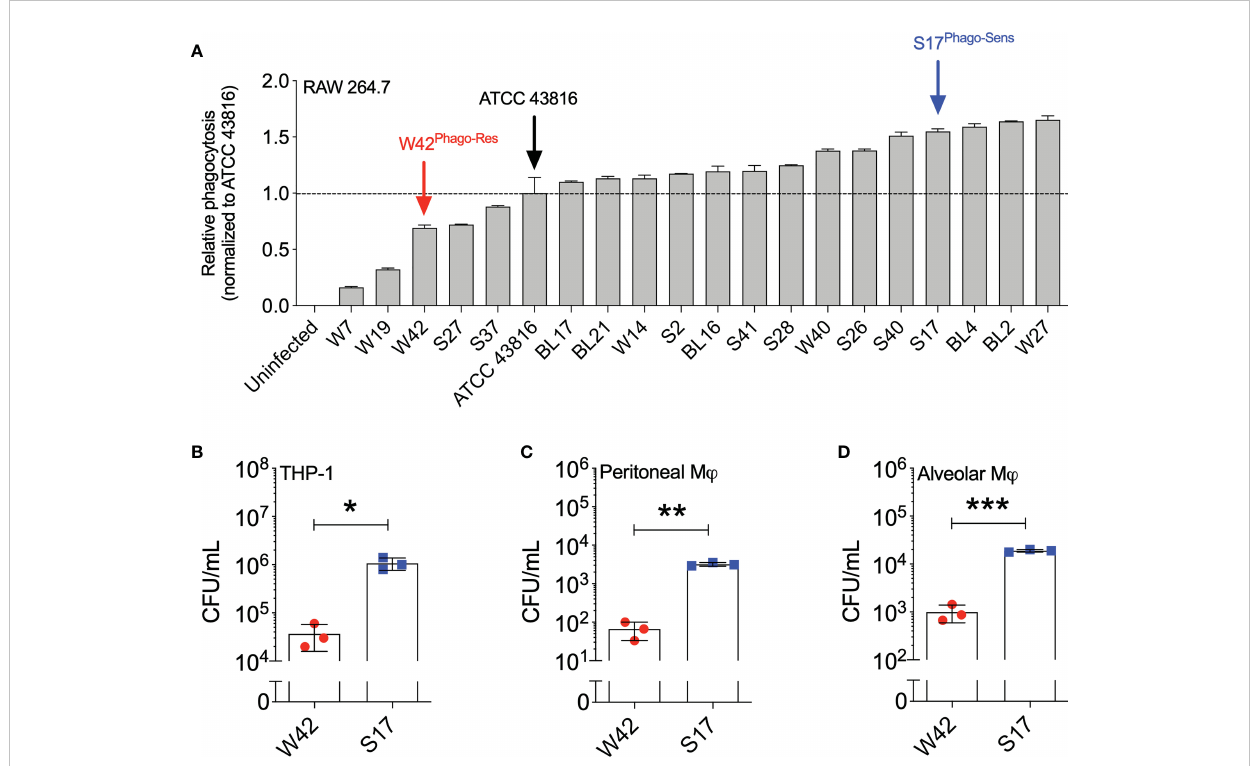
FIGURE 1 Kp clinical isolates show a high variation of phagocytic uptake by macrophages in vitro . (A) Heat-inactivated clinical Kp isolates (N=19) were labeled with pHrodo and incubated with RAW264.7 cells for 1.5 hours (MOI=10; bacteria:macrophage). Subsequently, the phagocytic uptake of Kp isolates by macrophages was analyzed by fl ow cytometry. (B) THP-1 cells, (C) mouse peritoneal macrophages, and (D) mouse alveolar macrophages were incubated with live Kp isolates W42 and S17 for 1 hour (MOI=10), after which phagocytic uptake of the bacteria was assessed by